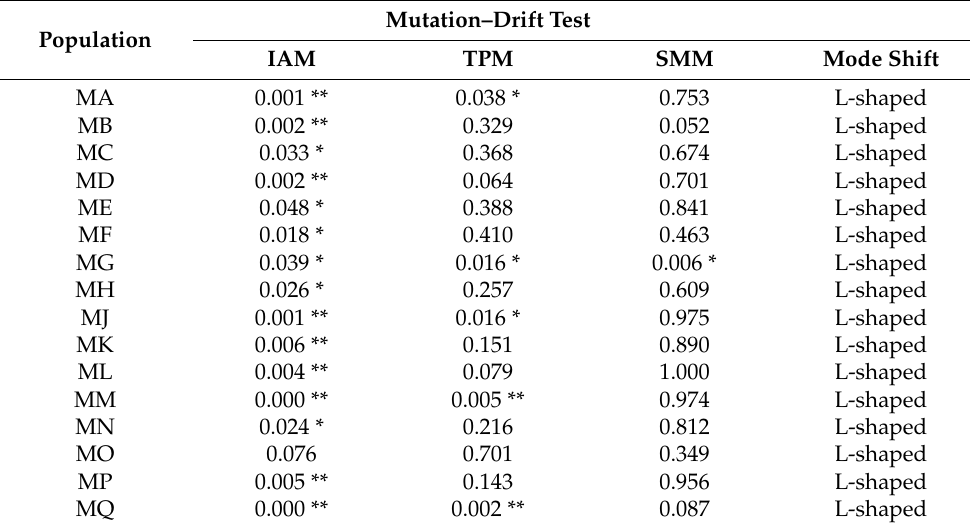
Table 3. Probabilities for mutation–drift equilibrium in 16 populations of P. persica under the three models with the Wilcoxon’s statistical tests. *, p < 0.05; **, p < 0.01. Mutation–Drift Test Population